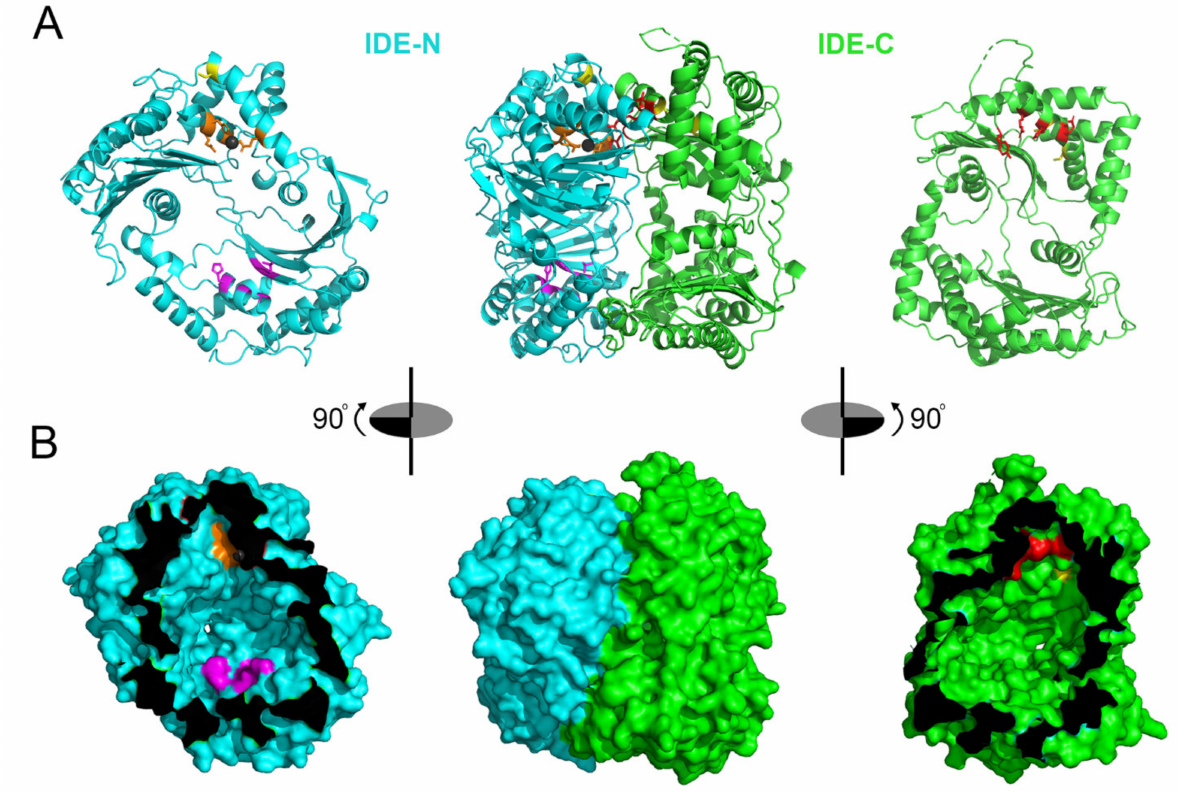
Figure 2. Structure of human IDE and regions targeted by different inhibitors. ( A , B ), Illustration of a single monomer of IDE (center) and IDE-N (left, cyan) and IDE-C (right, green) depicted in ribbon ( A ) and surface ( B ) representations. Zinc-binding and catalytic residues within the active site of IDE-N are depicted in orange, with the zinc atom shown as a gray sphere. Residues within IDE-C that make up the second portion of IDE’s bipartite active site are shown in red. Cysteine residues targeted by thiol-modifying inhibitors are shown in yellow. The distal exosite is shown in magenta. In ( B ), note that the portions of IDE-N and IDE-C that are adjacent when the protease is in the closed conformation are depicted in black. Figures generated in Pymol [169] from PDB 2G54